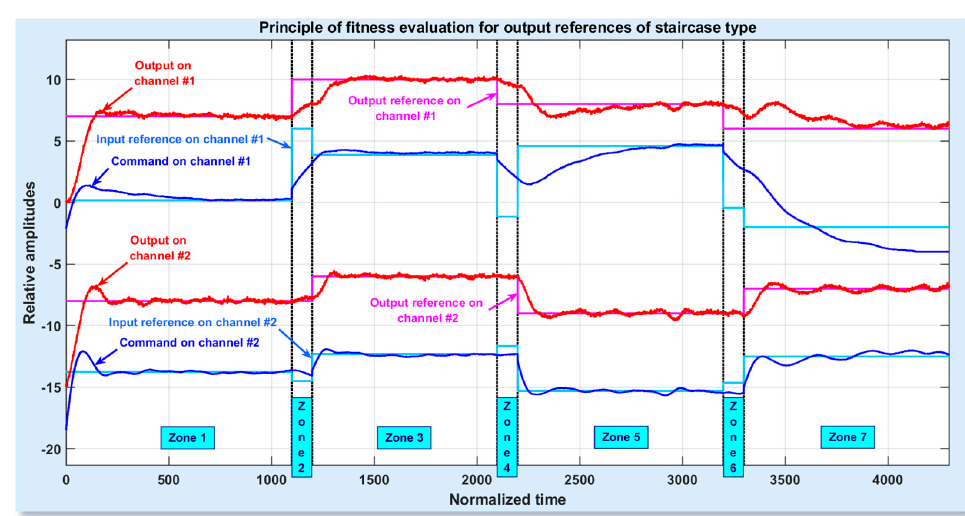
Figure C1. Principle of fitness evaluation for output references of staircase type. Figure A3. Principle of fitness evaluation for output references of staircase